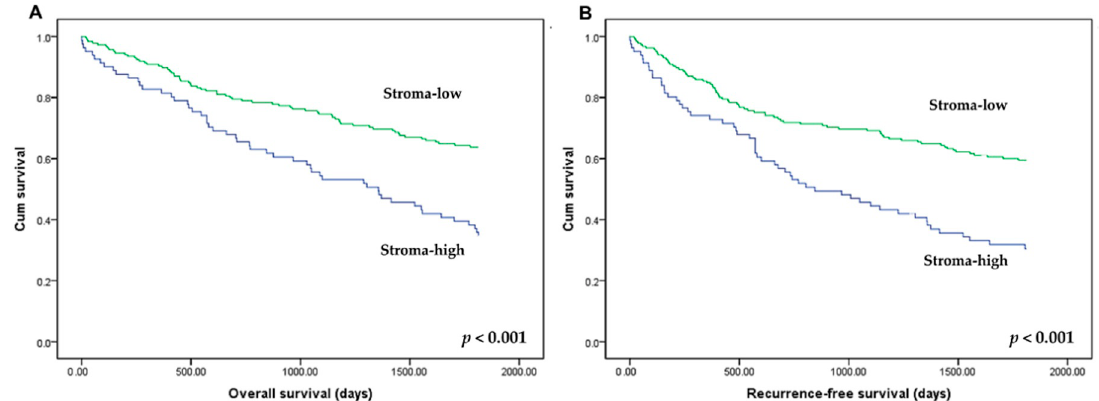
Figure 3. Kaplan–Meier curves for overall survival ( A ) and recurrence-free survival ( B ) according to the tumor–stroma ratio (TSR). Patients with stroma-high (low-TSR: ≤ 50% of tumor cells relative to stroma; blue line) and stroma-low (high-TSR: >50% of tumor cells relative to stroma; green line) showed overall and recurrence-free survivals.